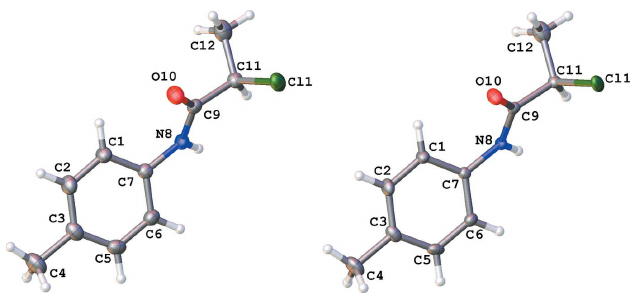
Figure 1 Molecular structures 1a and 1b showing the atom-numbering scheme. Only the major occupancy disorder components [ 1a 0.793 (4) and 1b 0.768 (2)] of the Cl1 and C12 positions are shown. Displacement ellipsoids drawn at the 50% probability level.